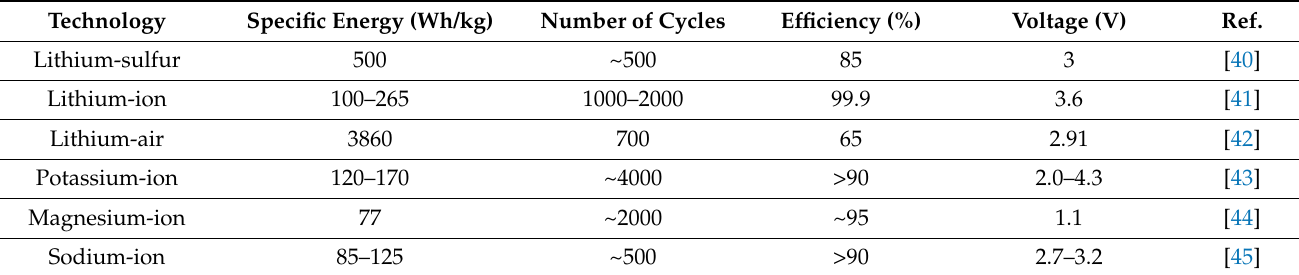
Table 1. Comparative analysis between different battery technologies. The variability of data for the same type of battery is due to the different active materials used for a given